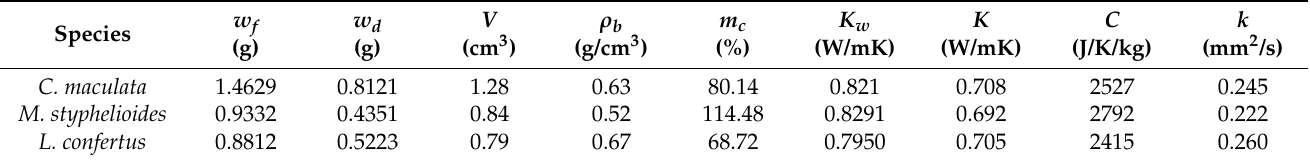
Table 3. Parameters used for estimating k for the C. maculata , M. styphelioides and L. confertus used in these